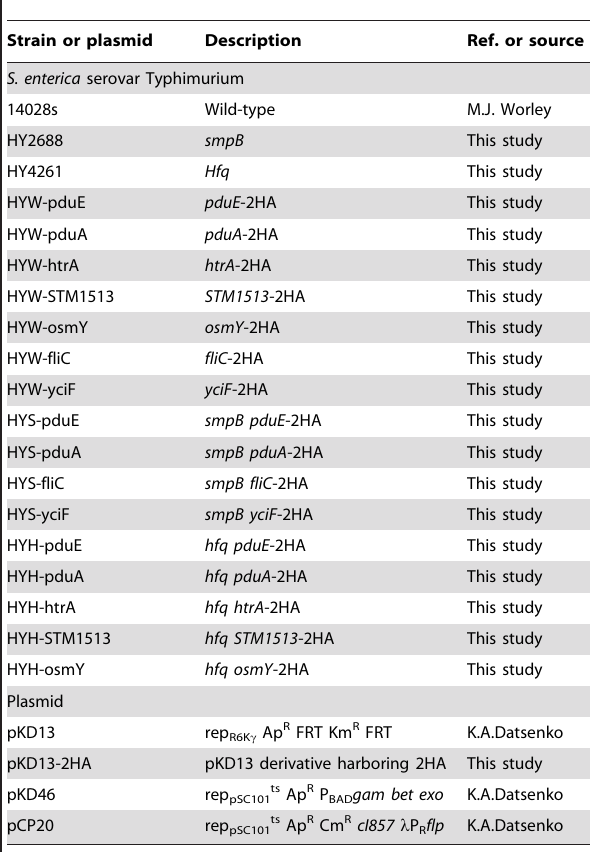
Table 2. Strains and plasmids used in this